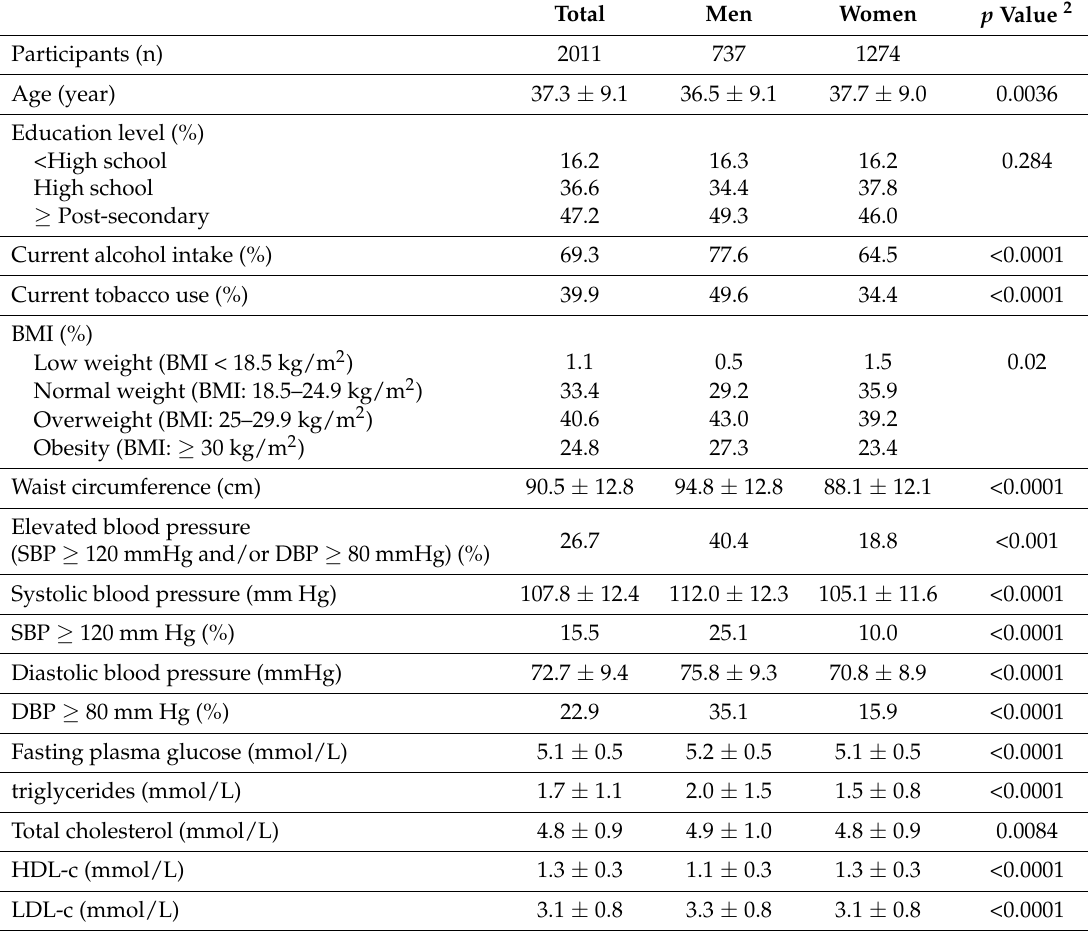
Table 1. General characteristics of the study sample by sex 1 .